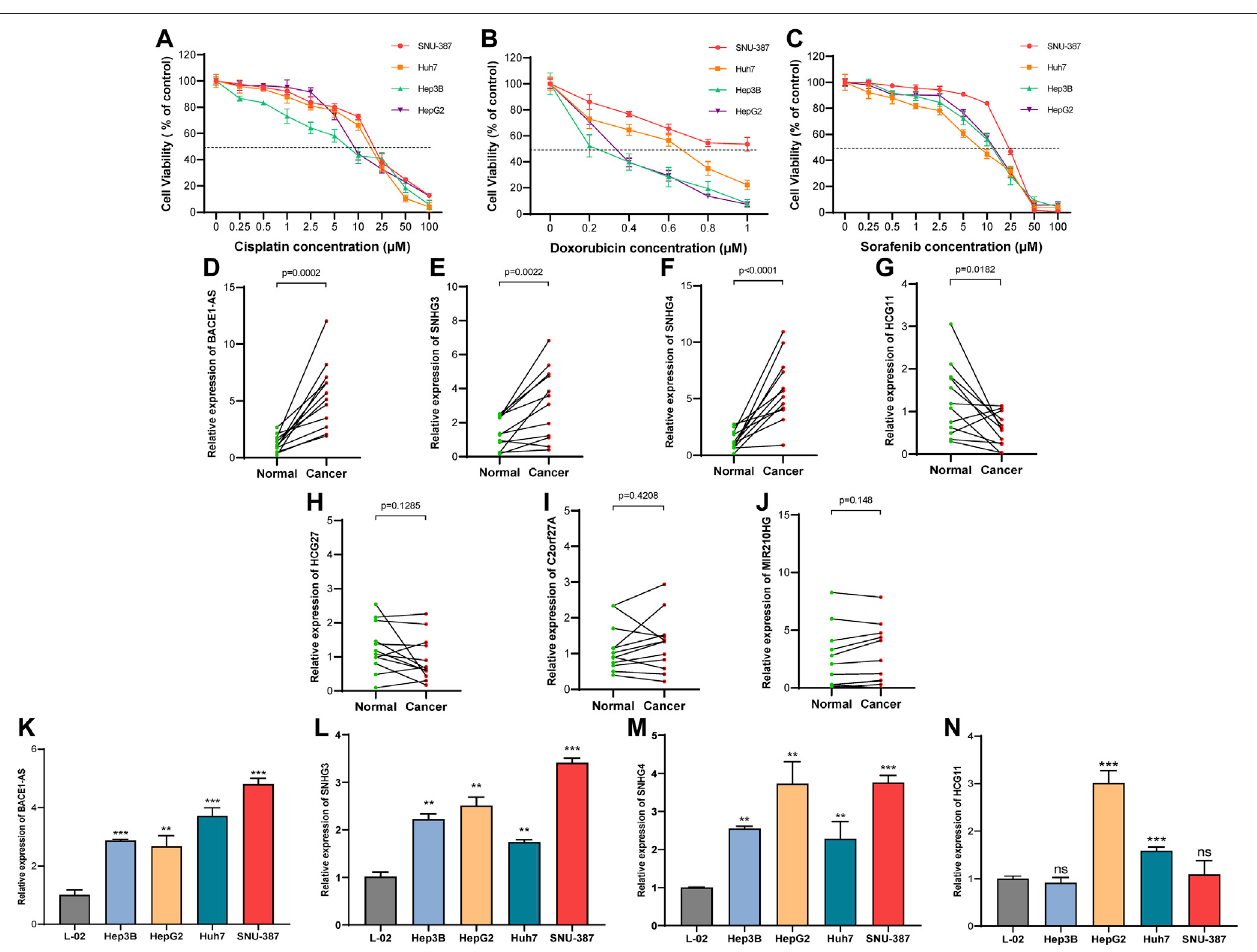
FIGURE13| ExpressionofNRLsinHCCpatients anddifferentdrug-sensitivecelllines. (A – C) CellviabilityinthefourHCCcelllines aftercisplatin,doxorubicin,and sorafenibtreatmentfor48 h.Dataarepresentedasthemean±standarddeviation( n =5). (D – J) RelativeexpressionofsevenNRLsinHCCpatients. (K – N) Expressionof BACE1-AS, SNHG3, SNHG4, and HCG11 in cell lines. (ns, p > 0.05; * p < 0.05; ** p < 0.01; *** p < 0.001; student t-test).